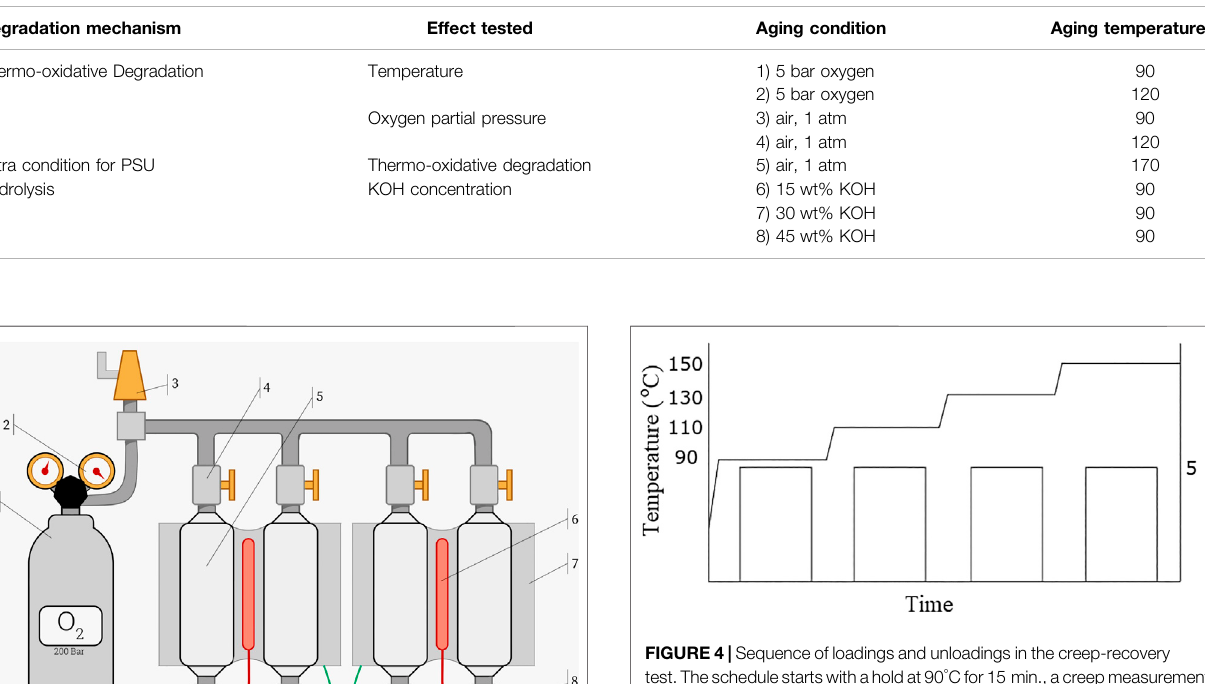
TABLE 2 | Overview of the aging conditions.